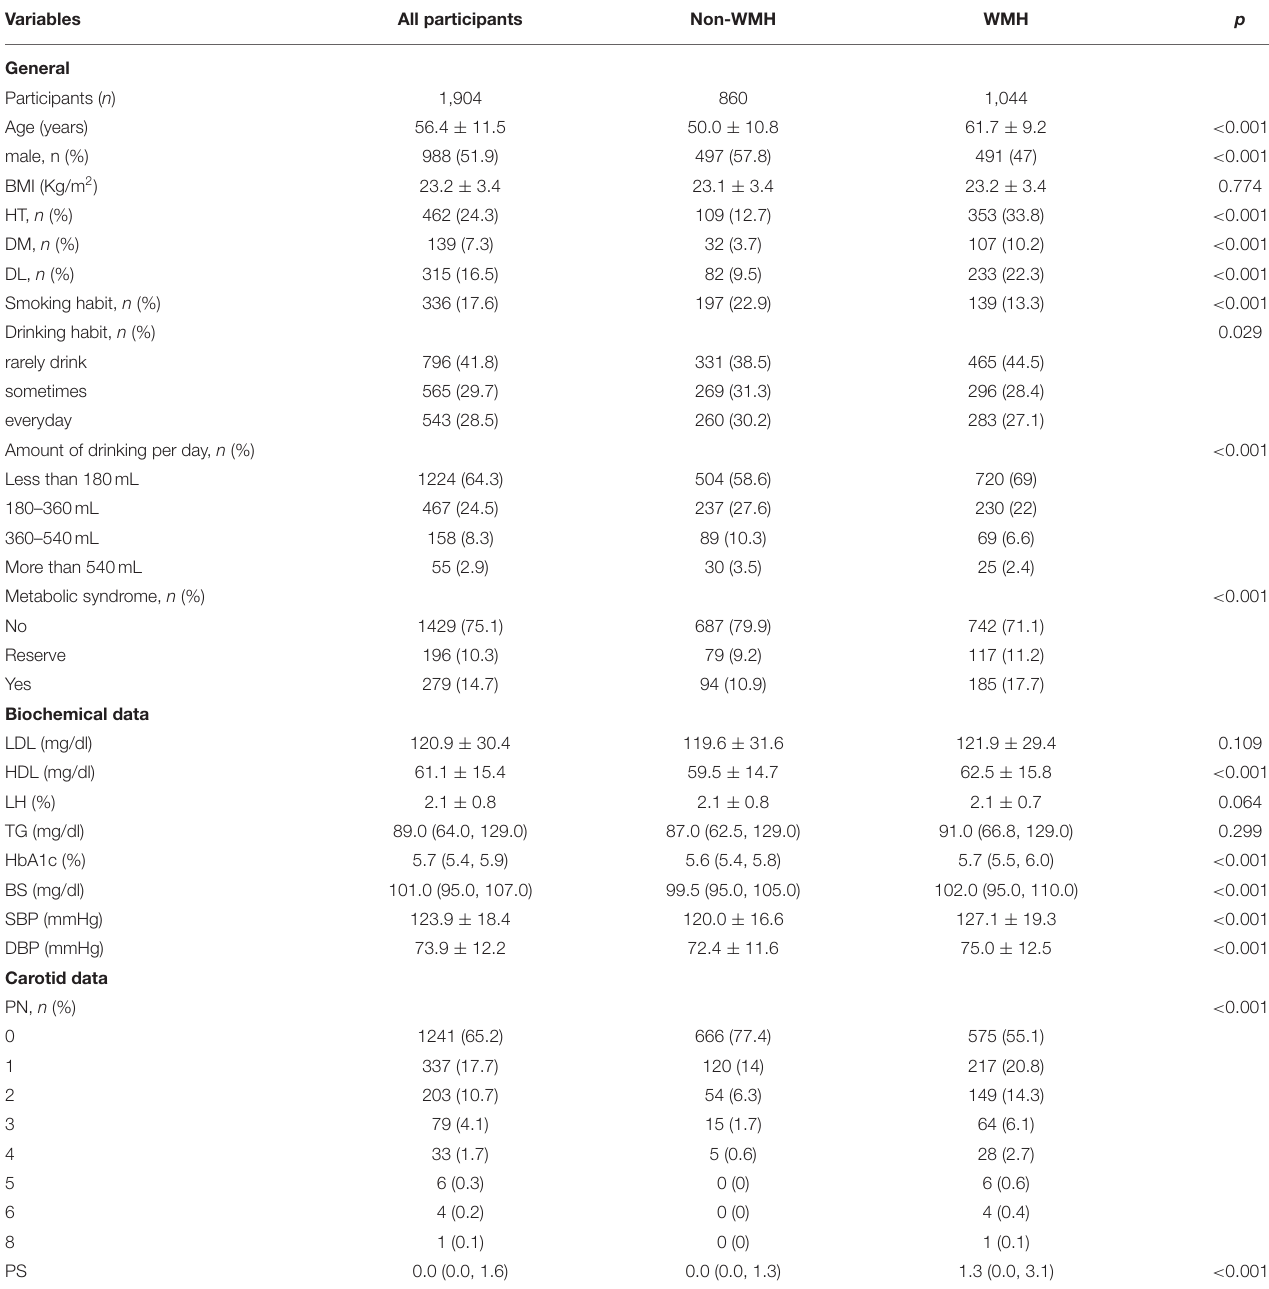
TABLE 1 | Comparison of clinical parameters between WML and non-WMH